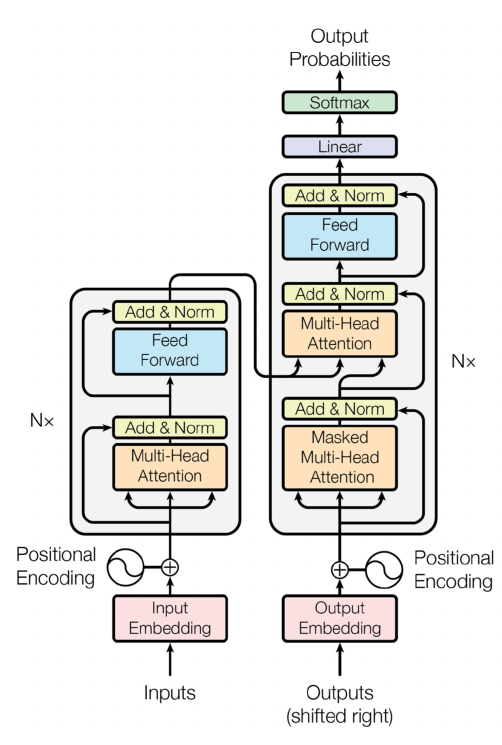
Figure 2. Traditional Transformer structure.